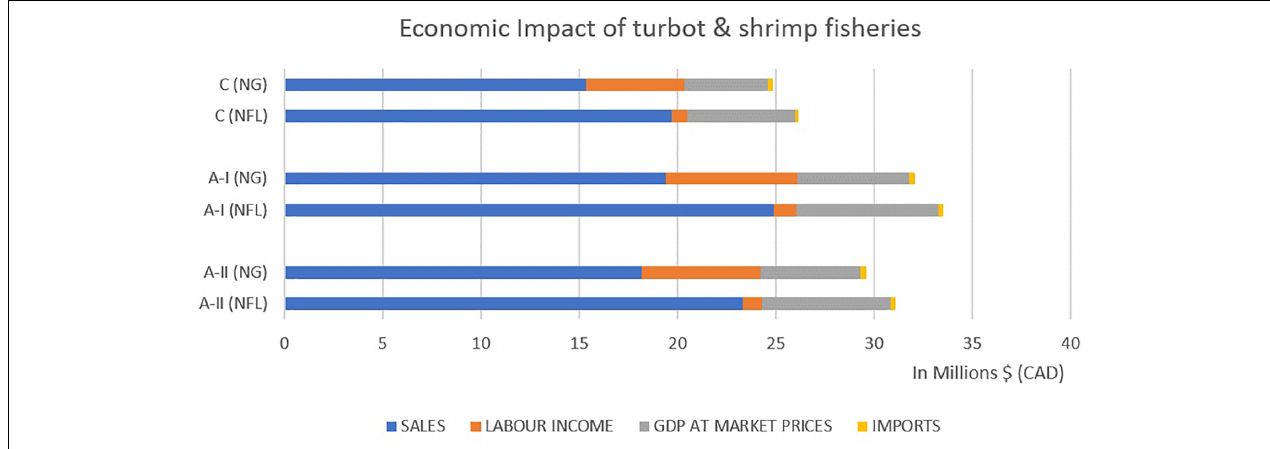
FIGURE 3 | Economic Impact of Nunatsiavut fisheries (NG), including impacts for the Newfoundland province (NFL) under 3 status of Allocations: (1) Current (C), (2) Advised-I (A-I), and (3) Advised II (A-II) Note that the magnitude of sales in this graph is likely an underestimate (18–19%) which results in a difference in the share of sales in the total economic impact of about 3–4%. The discrepancies in shares are due to differences in the price of shrimp used to derive impacts on labor income, GDP at market prices and imports which were estimated for 2017, using 2016 prices (ATN, 2018). In this example, we have used 2019 prices for sales to reflect the value of current and recently recommended allocations but have used estimates for labor income, GDP and imports provided in ATN